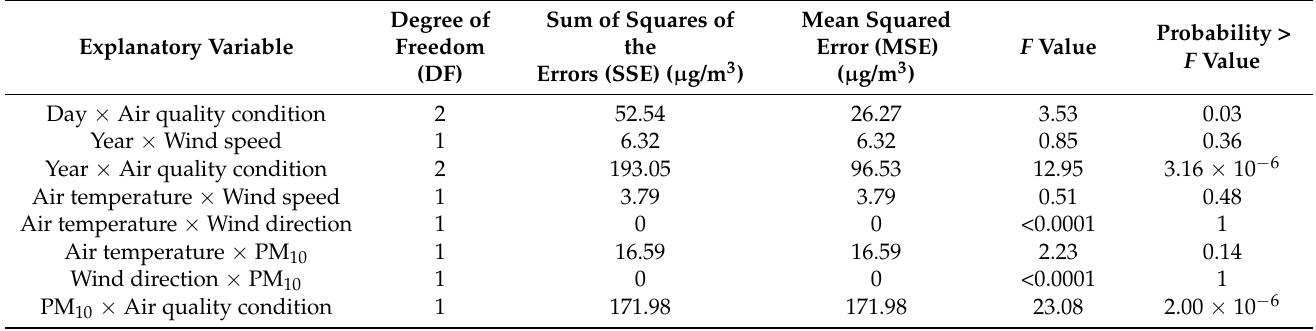
Figure 5. Scatter plots of estimated daily PM 2.5 concentration against observed daily PM 2.5 concen- tration in Singapore from March 2016 to February 2018 by ( a , b ) ANCOVA and ( c , d ) RFR models with learning and validation samples. Table 2. Results of sum of squares of the errors (SSE) analysis on the ANCOVA model for estimating daily PM 2.5 concentration in Singapore from March 2016 to February 2018 for selected explanatory